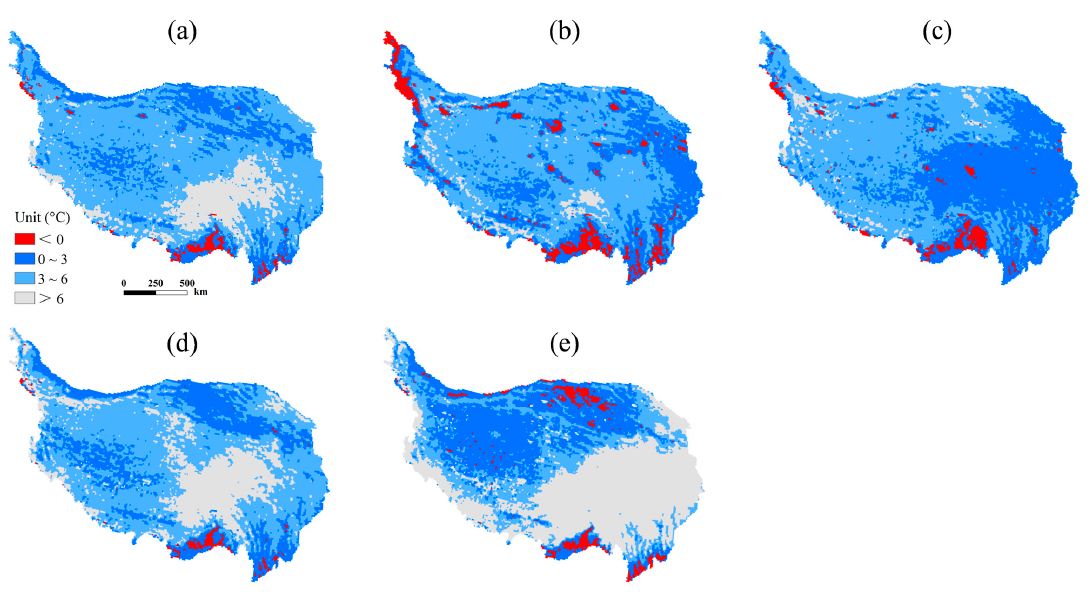
Figure 2. Geographic distribution of the mean Δ T on the QTP during the baseline period (i.e., 1981–2010); annual ( a ), spring ( b ), summer ( c ), autumn ( d ) and winter ( e ). The mean Δ T of the entire QTP was largest in winter (5.66 °C), followed by autumn (4.46 °C) and spring (3.25 °C), and smallest in summer (3.13 °C). Compared with the other three seasons, the total area with a negative value of Δ T was larger in spring and distributed mainly along the edge of the QTP, especially in the northwestern and south- eastern margins. The eastern part of the plateau had a low mean Δ T in summer, which increased gradually in autumn and reached a maximum in winter (Figure 2).